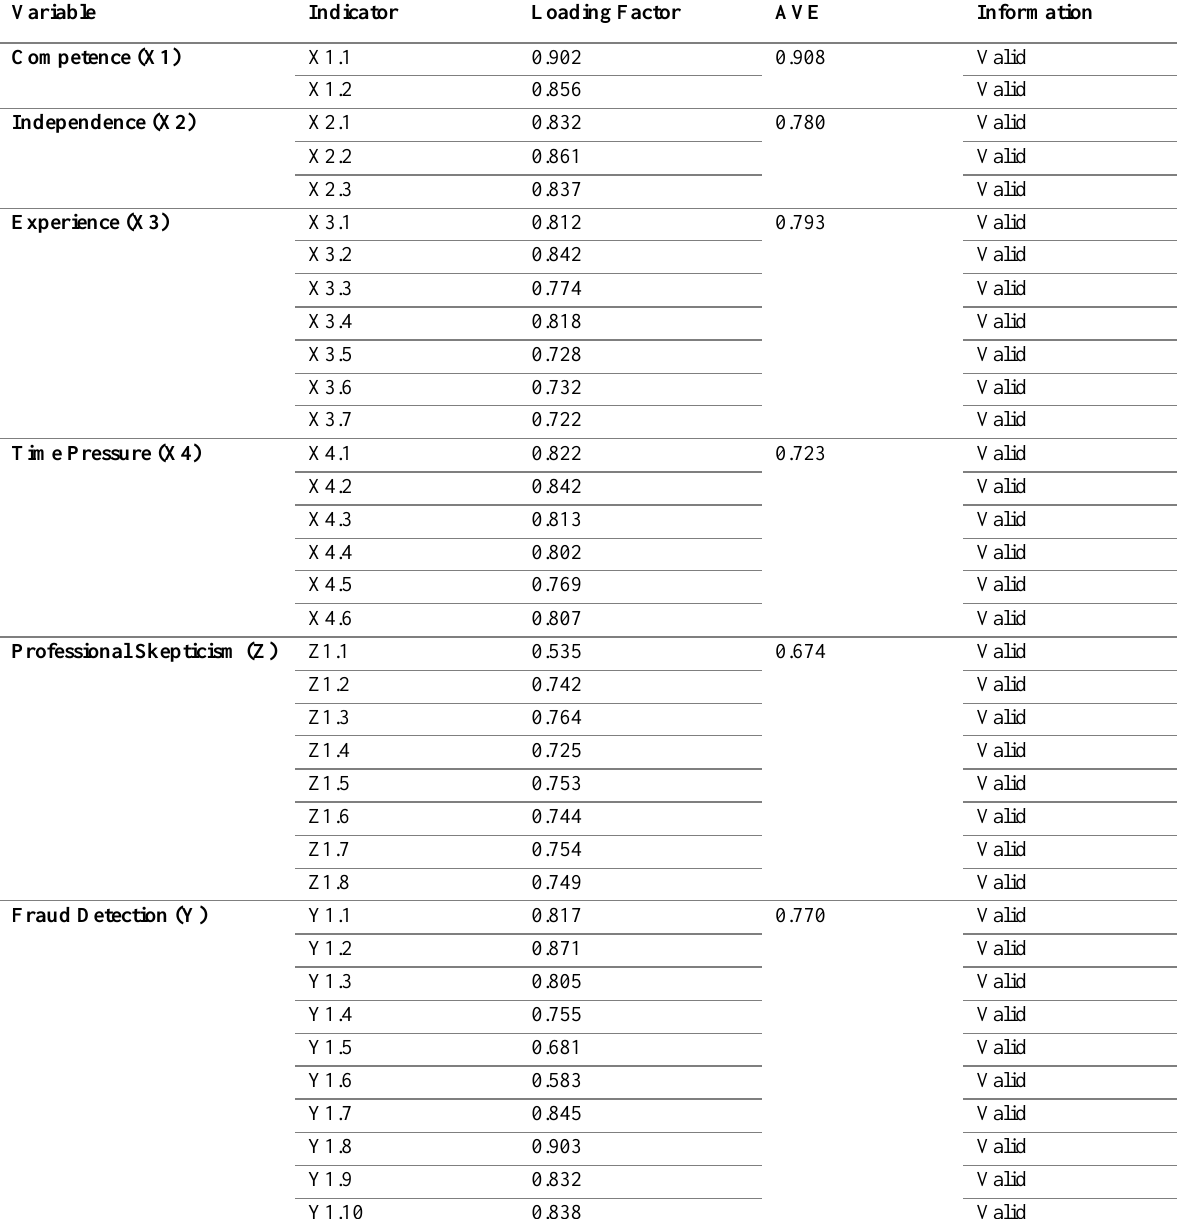
Table 1: Validity and Reliability Test